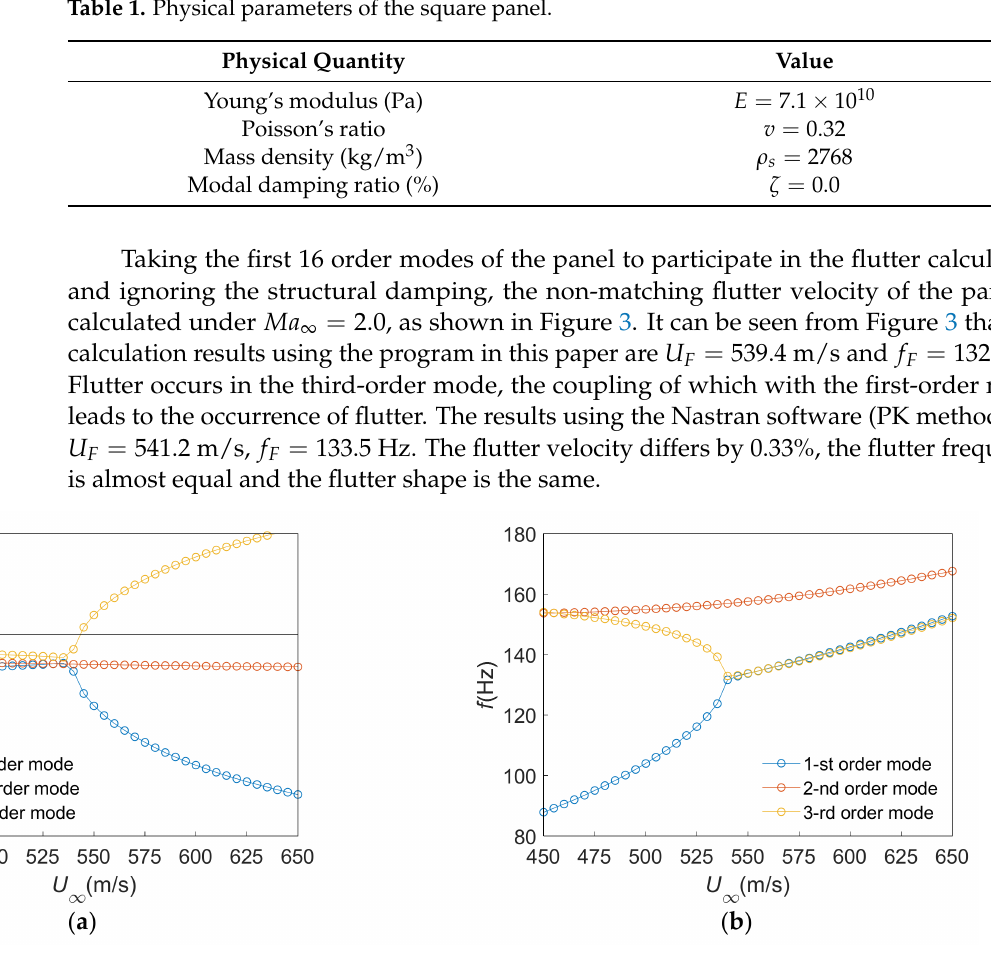
Figure 3. Results of flutter calculation ( Ma ∞ = 2.0): ( a ) U − g ; ( b ) U − f